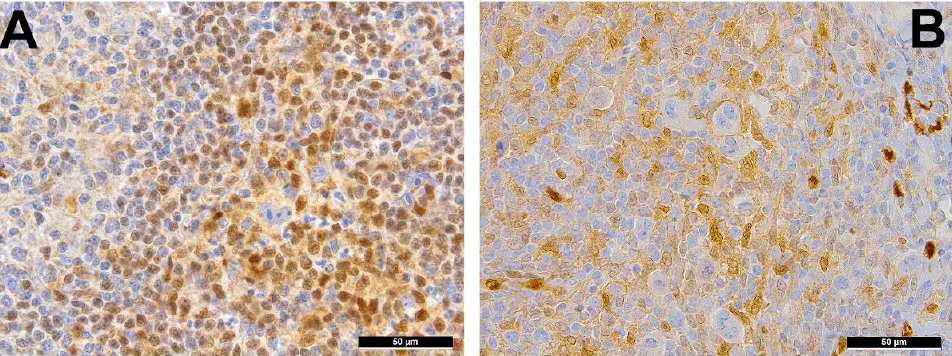
Figure 3 . ( A ) BOB1-negative Reed-Sternberg (RS) cell surrounded by BOB1 positive B-cells; BOB1 inactivation due to pro- moter hypermethylation of the respective gene in classic Hodgkin lymphoma (cHL). ( B ) SMAD1 negative RS cells sur- rounded by SMAD1 positive lymphocytes; SMAD1 is known to be hypermethylated in cHL and nodular lymphocyte- (cHL). ( B ) SMAD1 negative RS cells surrounded by SMAD1 positive lymphocytes; SMAD1 is predominant Hodgkin lymphoma.